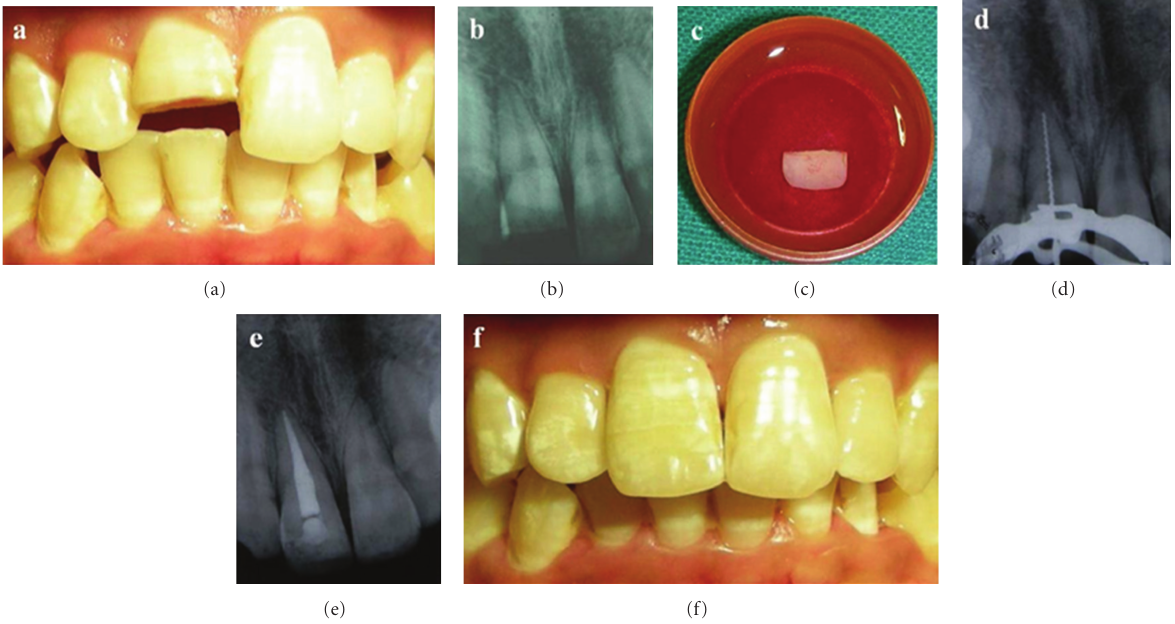
Figure 3: Reattachment of fractured tooth segment. (a) Clinical appearance of the patient, (b) preoperative radiograph, (c) fractured crown segment bought by the patient, (d) working length radiograph, (e) postoperative radiograph, and (f) clinical view after segment